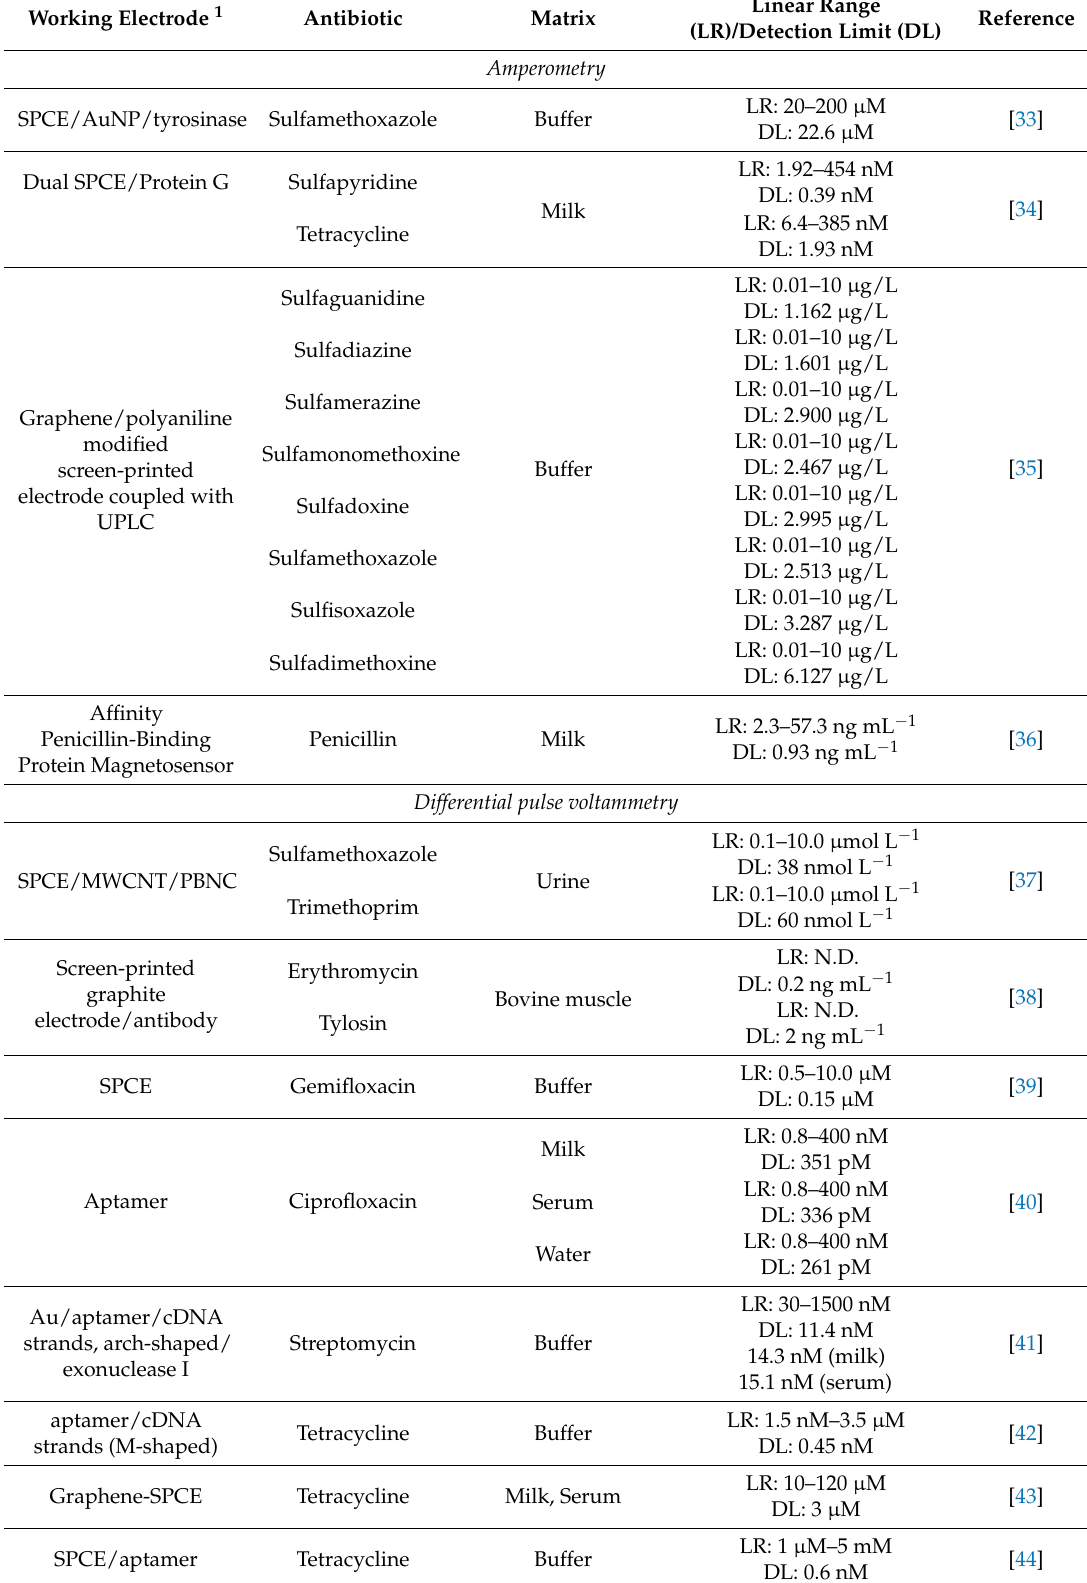
Table 1. Examples of (bio)sensors based on screen-printed electrodes for detection of antibiotics. Working Electrode